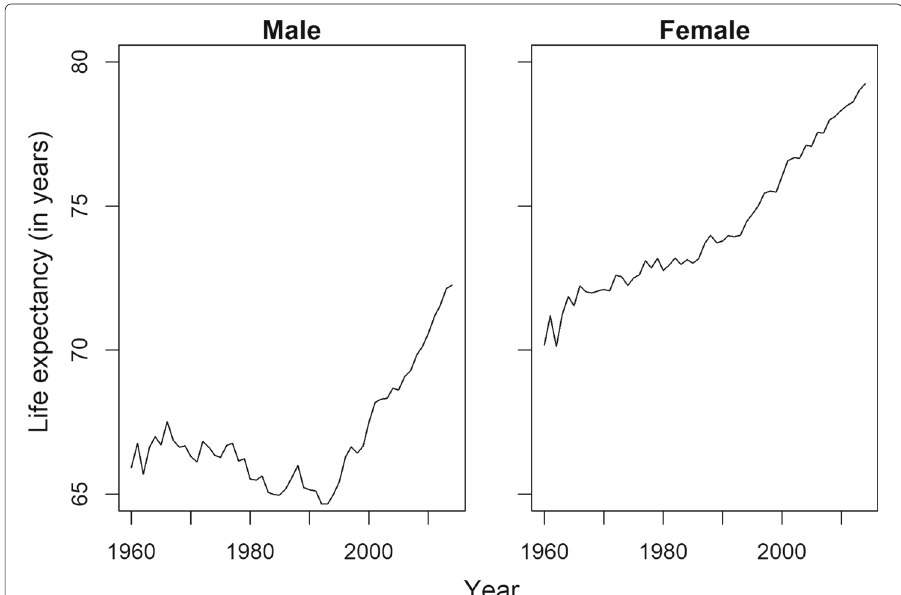
Fig. 2 Observed life expectancy at birth of Hungary (1960–2014)